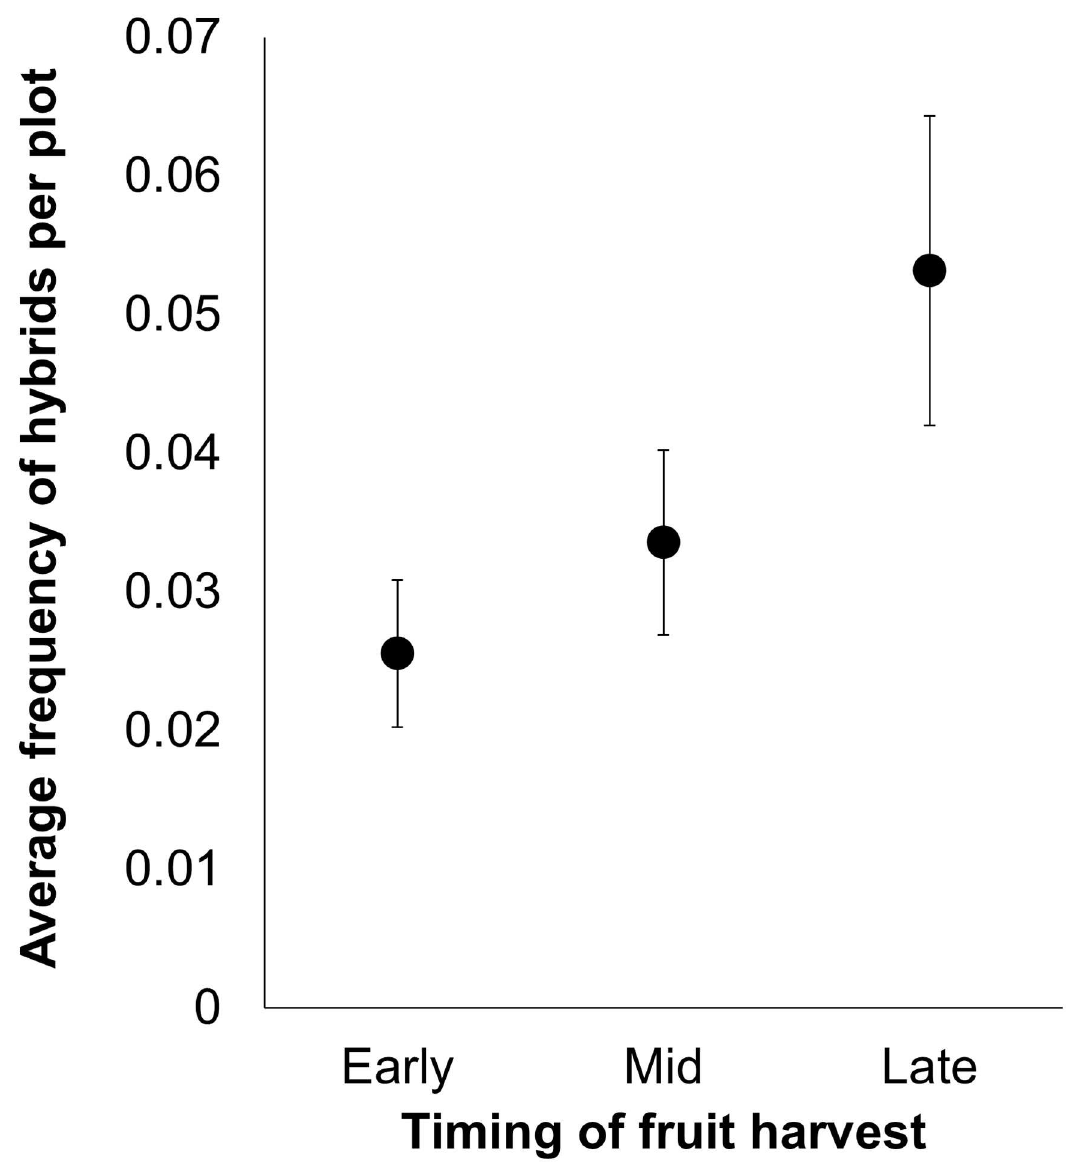
Fig 1. Least squares means ( ± 95% CI) of the frequency of Raphanus raphanistrum x R . sativus hybrid progeny produced as predicted by the date of fruit harvest(early-, mid- or late-season). Overall means for each treatment are represented by black